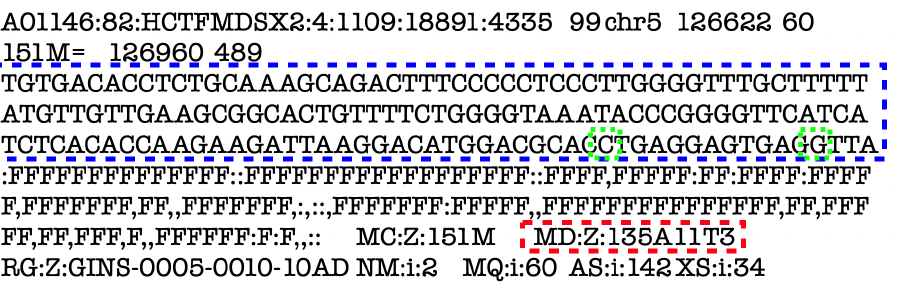
Figure 4. An example of a line in a gene data